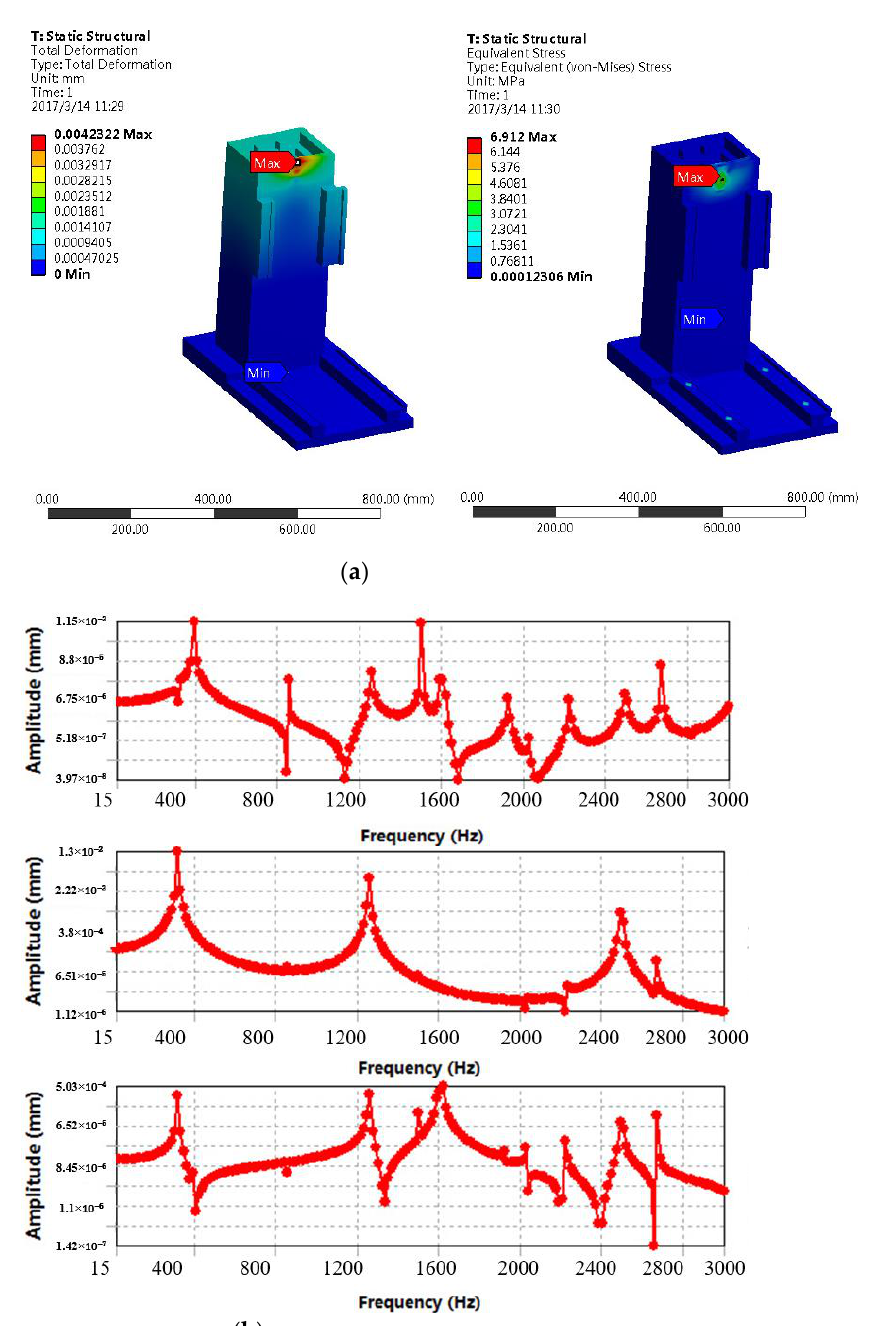
Figure 16. The lower limit of the optimized integral bed structure. ( a ) Static deformation and stress distribution, ( b ) Harmonic response in X/Y/Z directions.